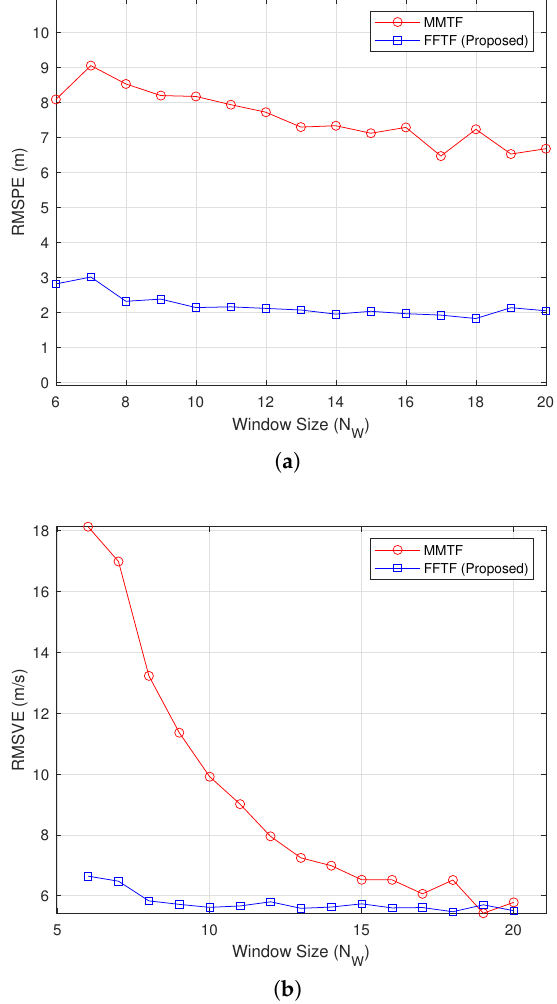
Figure 4. Simulation results under the getting closer scenario ( V r = − 20 km/h): ( a ) RMSPE; ( b ) RMSVE.